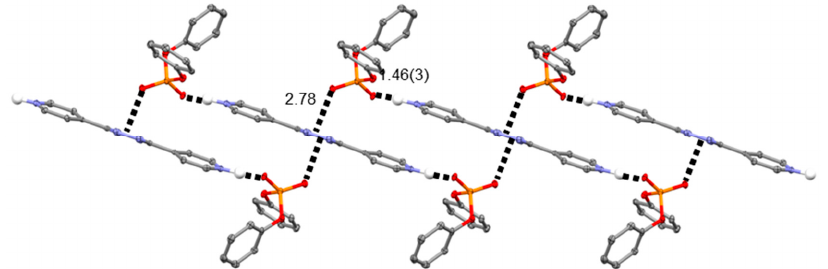
Figure 4. The infinite net ribbon formed by H 2 L 2+ and diphenylphosphate ions in H 2 L(Ph 2 PO 4 ) 2 . N–H ··· O (salt bridge) and O ··· π (anion– π ) contacts are displayed. All distances are in Å. Color code: C, grey; H, white; N, blue; O, red; P, orange. Molecules 2018 , 23 , x